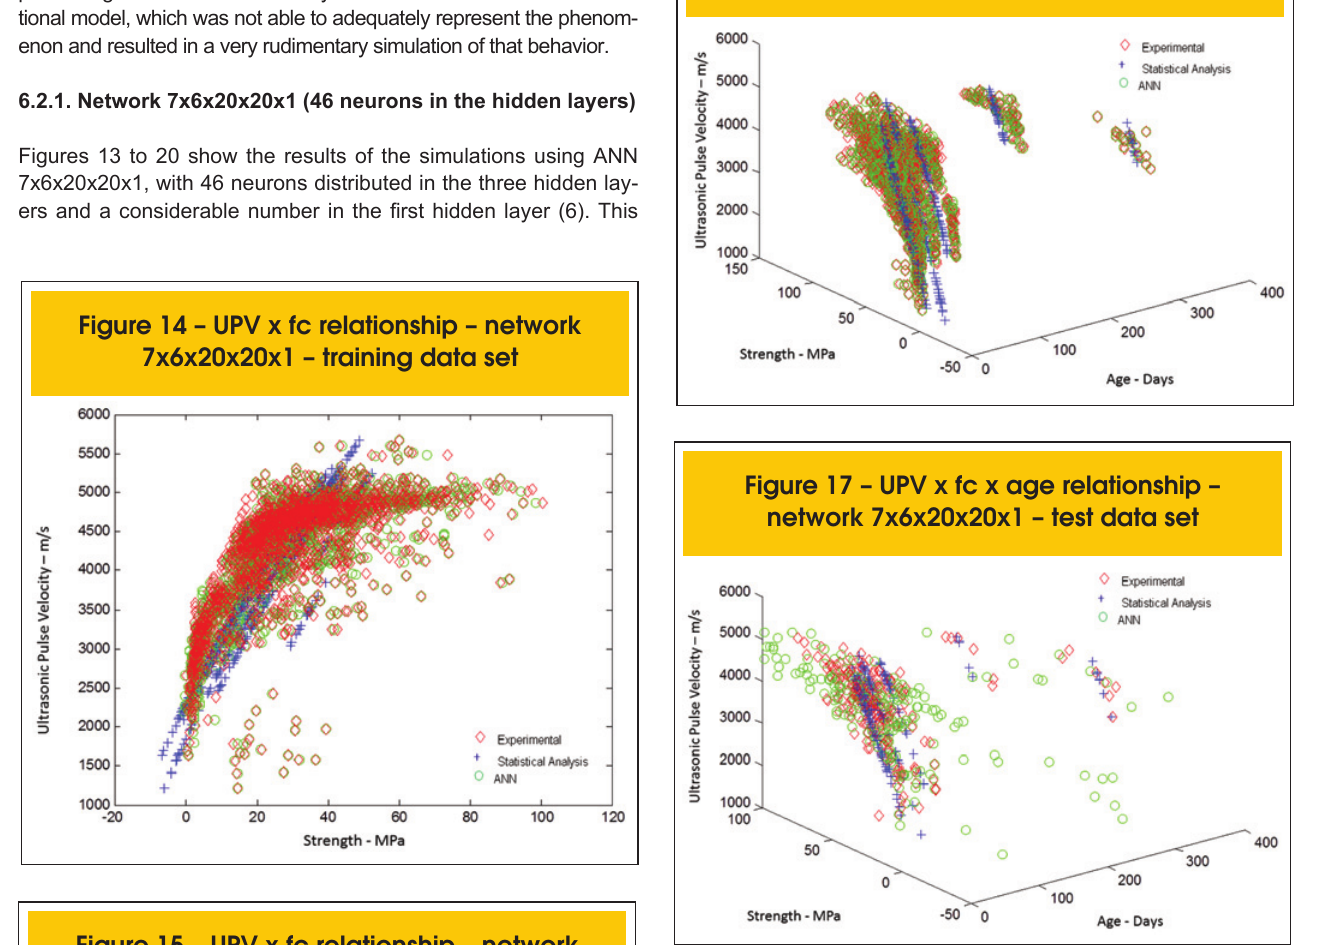
Figure 15 – UPV x fc relationship – network 7x6x20x20x1 – test data set